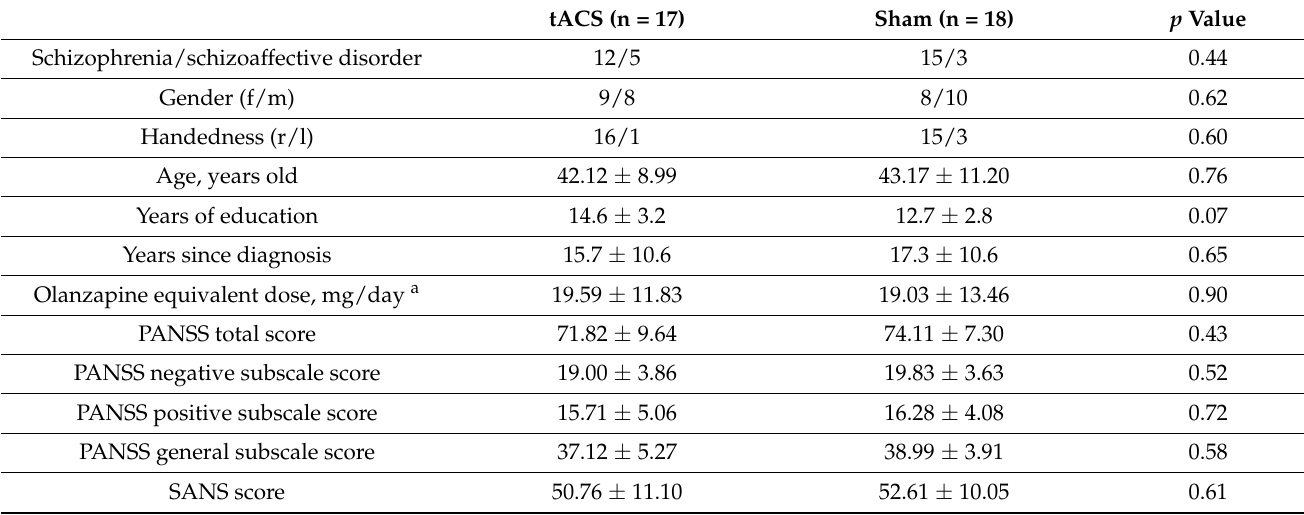
Table 1. Concise demographics and clinical data of the participants.